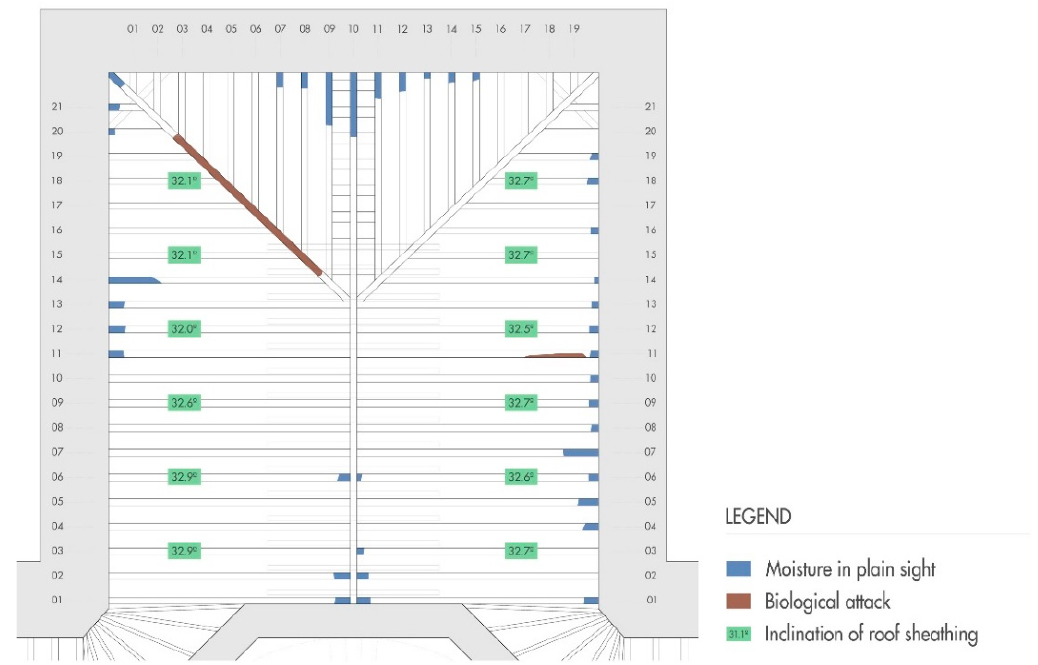
Figure 13. Results of deformation measurements and organoleptic inspection.